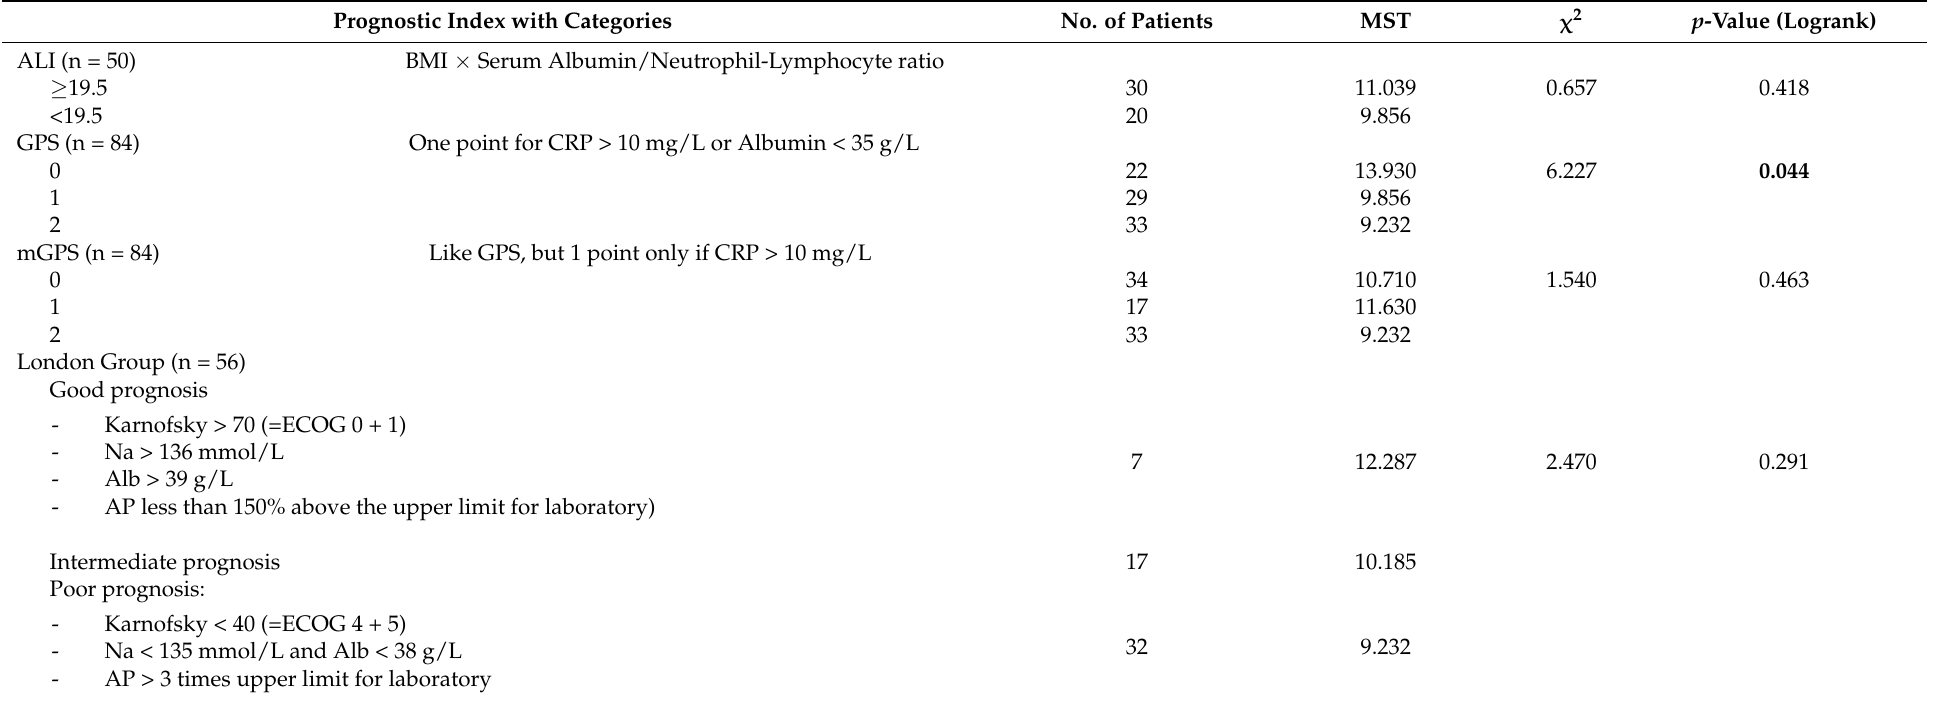
Table 4. Univariate analysis of staging